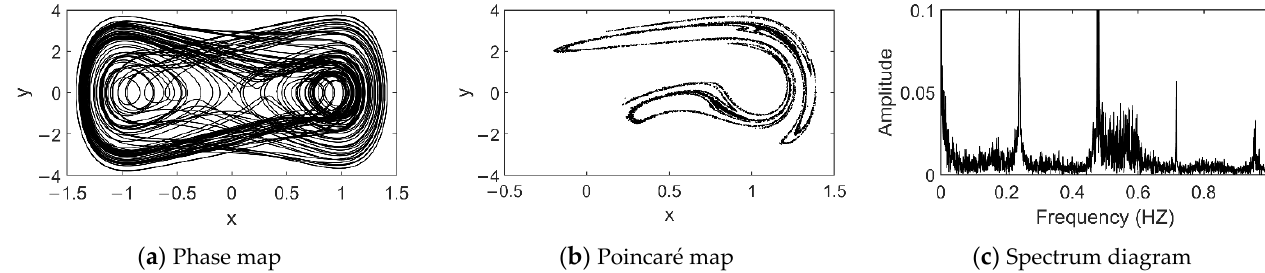
Figure 12. Chaos of the system (5) for f 0 = 4.2.